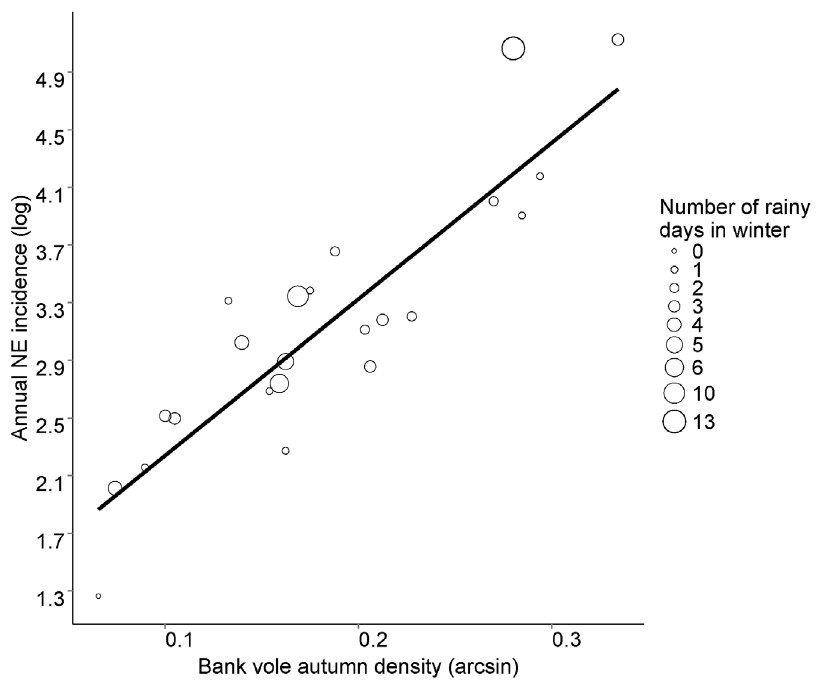
Figure 4. Relationship between annual (July–June) nephropathia epidemica (NE) incidence (log-transformed) in N. Sweden and bank vole autumn density in 1990–2012 (arcsine transformed). The size of circles is proportional to the number of rainy days in winter. Both vole density and number of rainy days were significant predictors of NE incidence (p , 0.001 and p , 0.05, respectively, n=24).